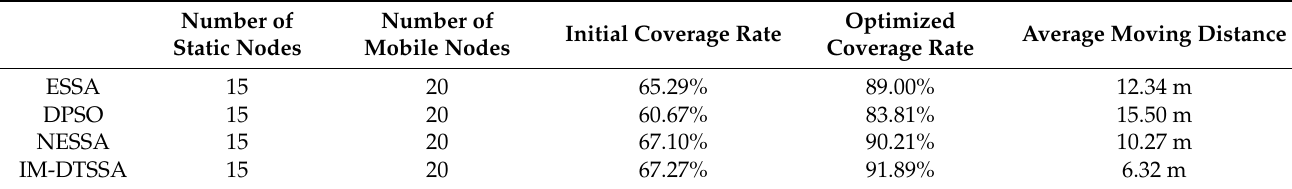
Table 2. Comparison of WSN performance in the area of 50 m × 50